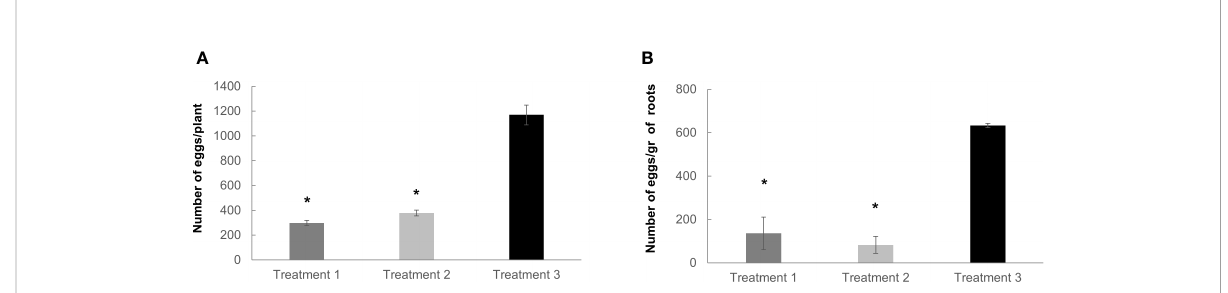
FIGURE 7 Nematode reproduction analysis after dual-strain bacteria treatments in tomato plants. The number of eggs obtained in tomato ( Solanum lycopersicum ) var. Rome inoculated with 400 J2/plant of M. javanica was quanti fi ed in all cases, (A) per plant, and (B) per gram of roots weight. Treatment 1 (irrigated with dual-strain bacteria combination, day 1, and inoculated with M. javanica , day 3); treatment 2 (inoculated with M. javanica. day 1, and irrigated with dual-strain bacteria combination, day 3) and treatment 3 (inoculated with M. javanica , day 1, and irrigated with only tap water, day 3). Treatment 3 was used as control of nematode infection. Number of eggs were scored eight weeks post inoculation (from day 1). Bars represent mean ± SE, n=24 plants tested per treatment in three independent experiments. Concentration of 1x dual-strain bacteria combination of B paralicheniformis FMCH001 and B subtilis FMCH002, 3,2 x 10E+08 CFU/ml. Statistics are always comparisons to treatment 3 as a control. *Asterisks represent signi fi cant differences (t-test; P <